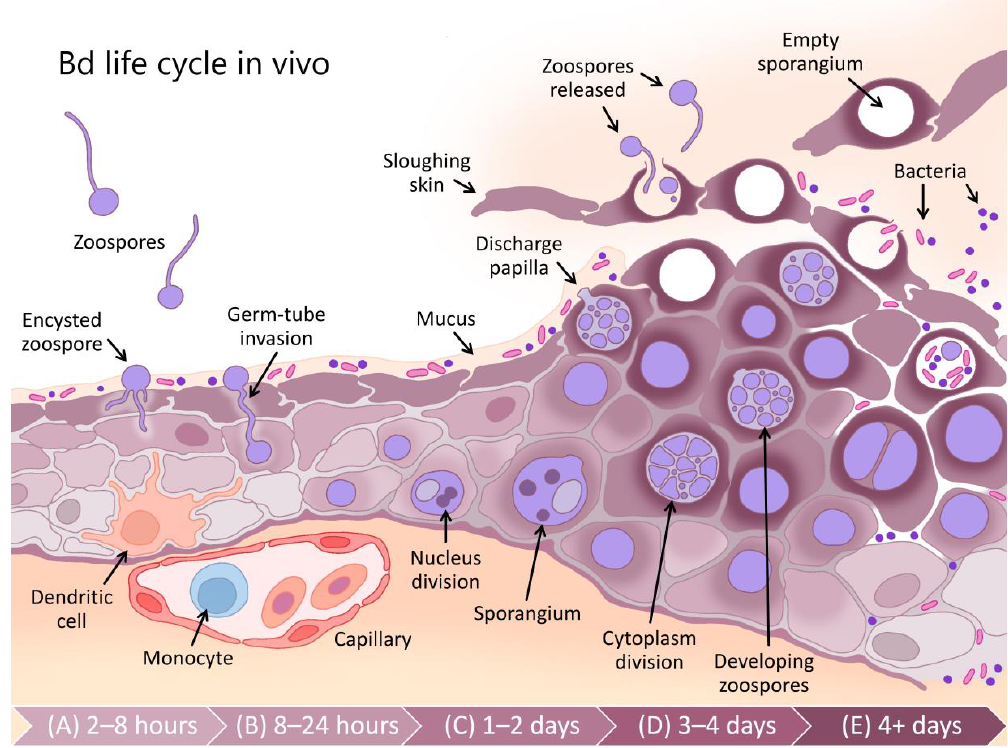
Figure 1. Schematic of the in vivo life cycle of Batrachochytrium dendrobatidis (Bd) depicting a microscopic cross-section of amphibian skin (cellular epidermis) and the process of Bd invasion, replication and release. Approximate times/stages during the initial infection process are depicted from left to right ( A – E ). Bd is depicted in violet and host skin cells are depicted in mauve, with increasing cell keratinisation being darker. During the first 2–8 h post exposure ( A ), free-living infectious zoospores undergo chemotaxis towards the skin surface using their motile flagellum, where they encyst into a thallus, absorb the flagellum and develop rhizoids. From there ( B ), they produce a germ tube through which they inject their contents into deep cells of the host epidermis. From 1–2 days post exposure ( C ), the developing sporangium undergoes division of its nucleus, then cytoplasm, yielding individual zoospores which develop inside the sporangial capsule. These zoospores are then released through a discharge tube ( D ). Note that the infected skin demonstrates cellular hypertrophy (larger cells), epidermal hyperplasia (increased thickness due to an increase in cell number), hyperkeratosis (increased cellular keratin shown in darker mauve), and skin sloughing becomes dysregulated. Continued infection ( E ) disrupts the integrity of the epithelial barrier, permitting secondary bacterial